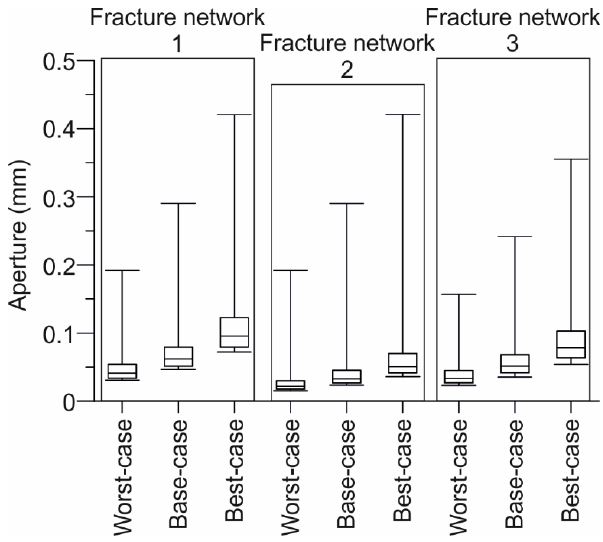
Figure 7. Boxplot of initial fracture aperture with whiskers from minimum to maximum. The reader is referred to Section 4.2 for further details on the fracture network and to Table 1 for further information on the properties of the medium.